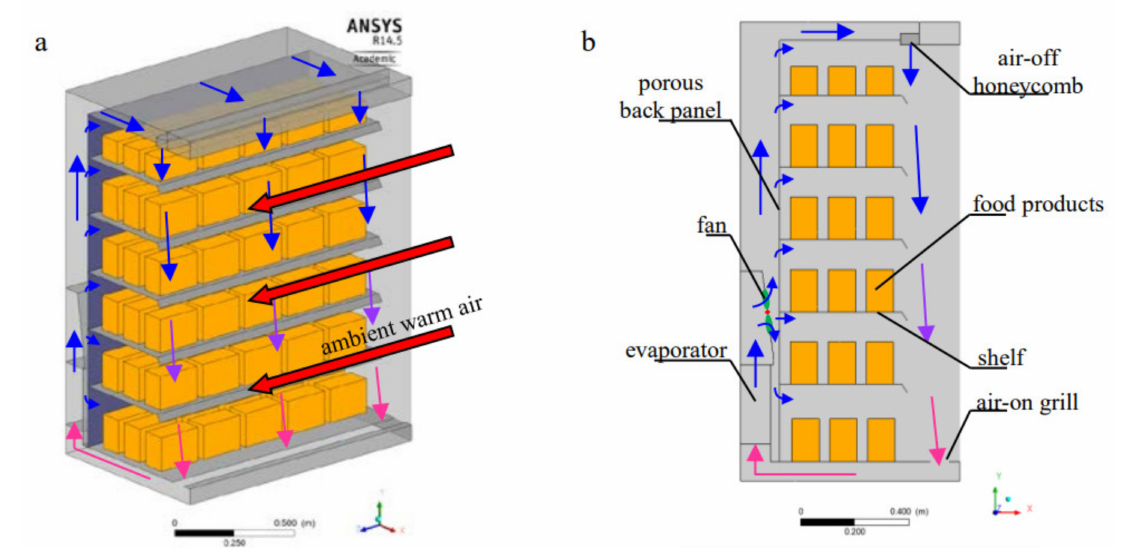
Figure 6. Illustration of the structure of the conventional refrigerated cabinet: ( a ) 3D structure; ( b ) 2D structure [41]. Reprinted with